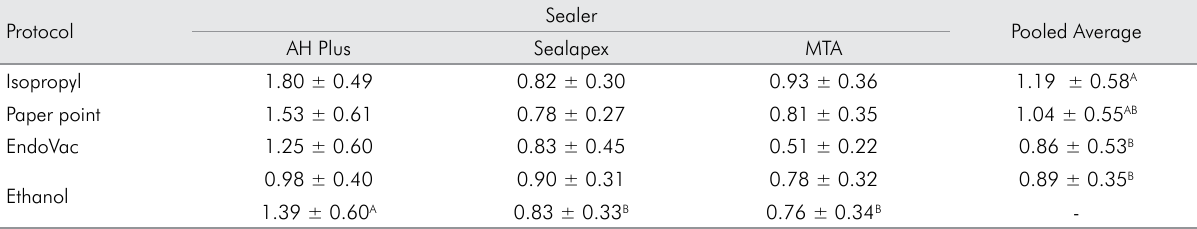
Table 3. Mean ± SD of the BS of the three thirds according to sealer and protocol used. Protocol